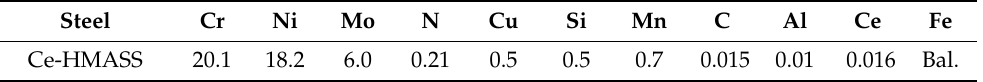
Table 1. Chemical composition of the Ce- high Mo austenite stainless steel